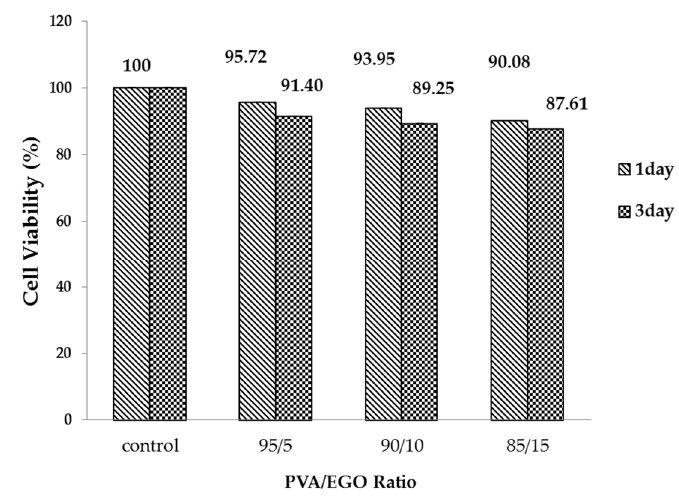
Figure 6. Cell viability of PVA/EGO nanofibrous membranes as related to the culture time (one and three days). The count of fibroblast is 5 × 10 3 cells/well.